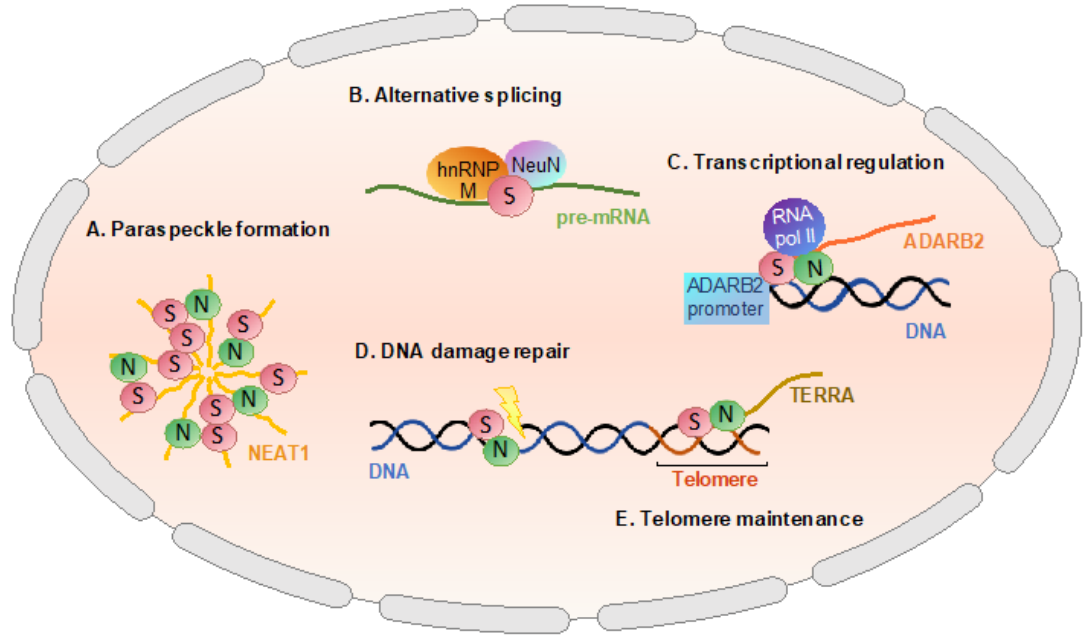
Figure 2. The nuclear function of SFPQ. SFPQ is critical for the structural integrity of paraspeckles ( A ). SFPQ interacts with other splicing factors such as hnRNP M and NeuN to regulate alternative splicing of pre-mRNA ( B ). SFPQ acts as an important transcriptional coactivator by interacting with RNA Polymerase II ( C ). SFPQ is also involved in DNA damage repair—both in homologous repair and nonhomologous end-joining pathways ( D ). SFPQ facilitates telomere maintenance, interacting with a telomere repeat-containing long noncoding RNA, TERRA ( E ). SFPQ is depicted as red circles labeled with “S” while its dimerization partner NONO as green circles with “N”.